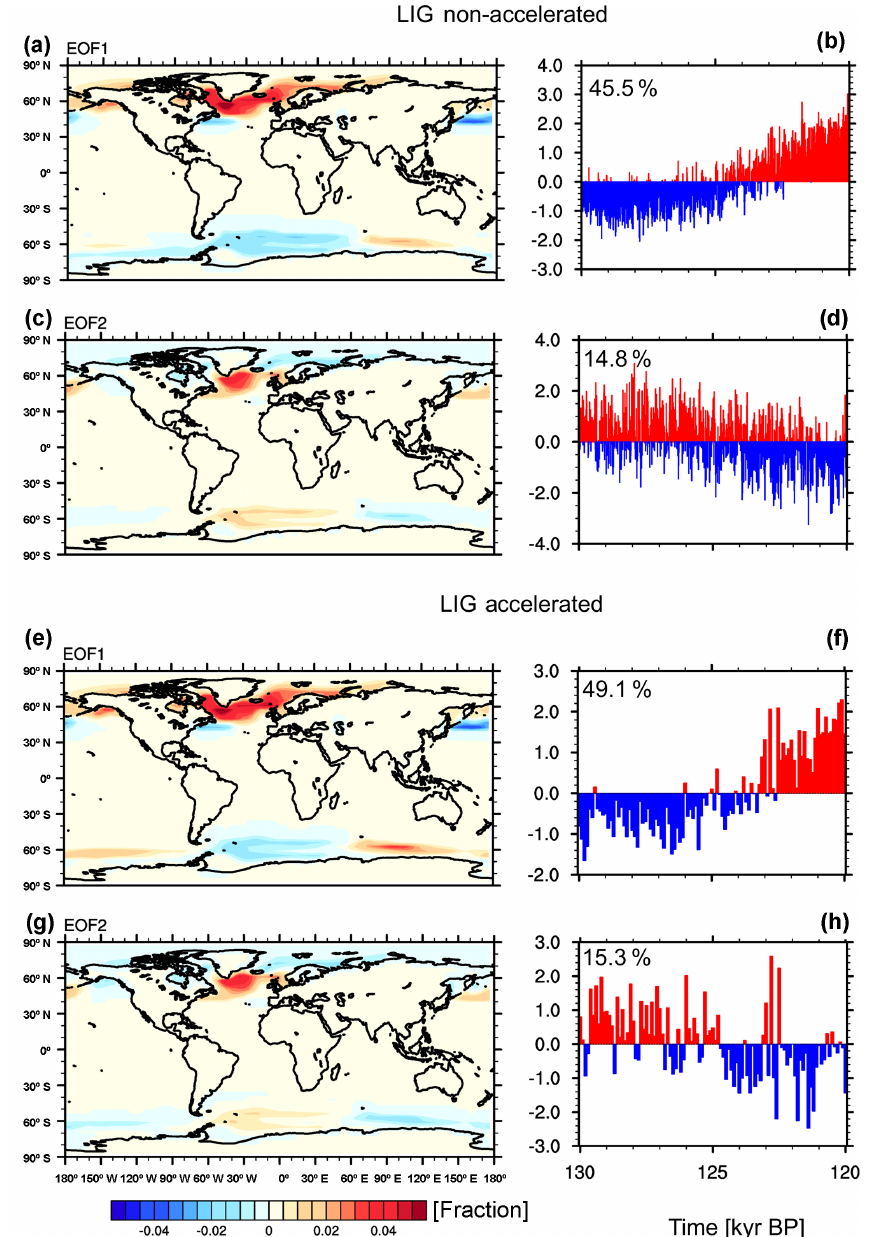
Figure 8. Same as Fig. 5 but for LIG sea-ice